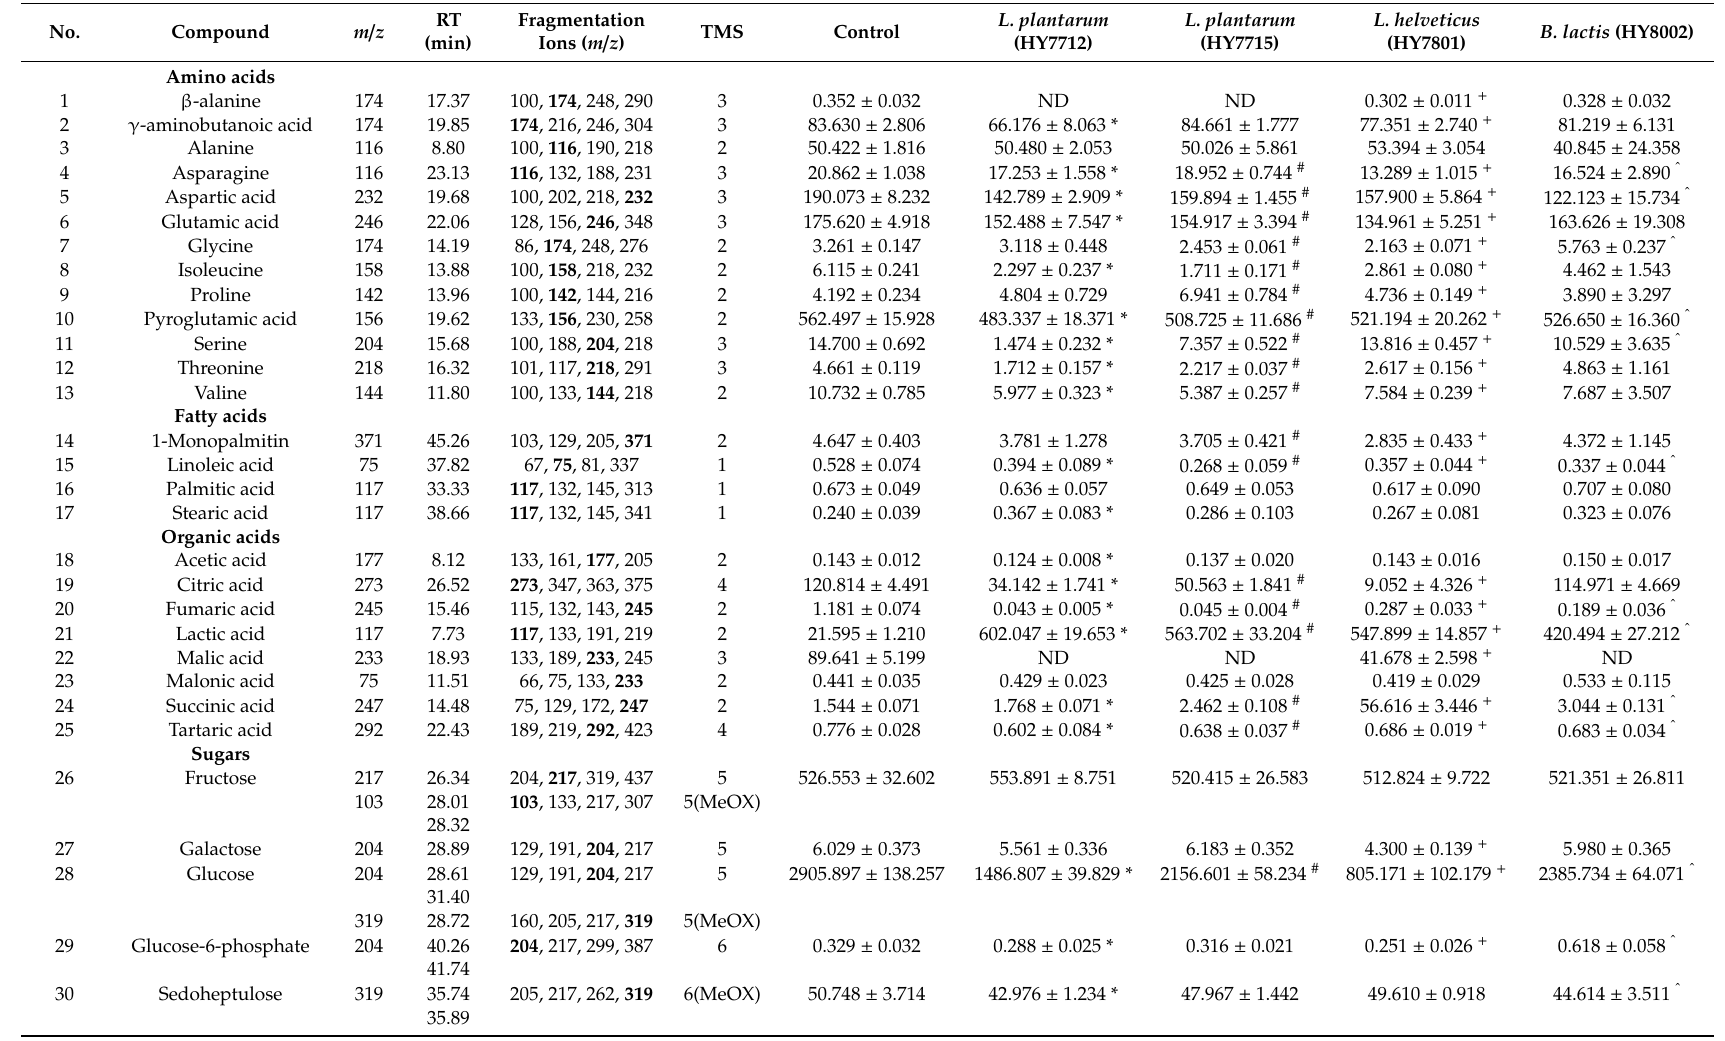
Table 1. Relative levels of metabolites in the fermented and non-fermented VJs, as detected by